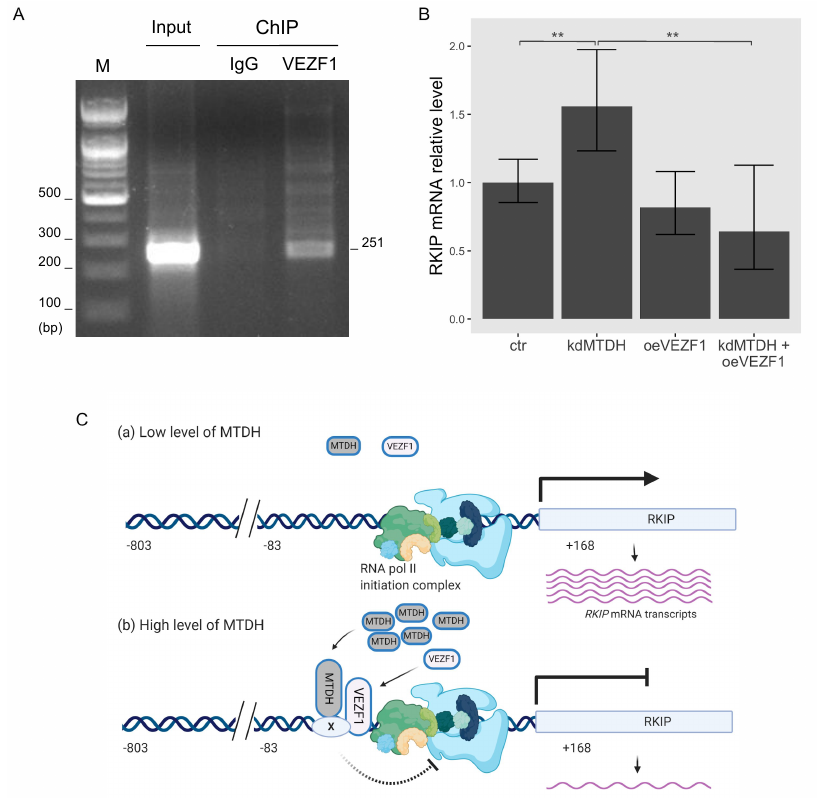
Figure 5. Functional linkage between VEZF1 and MTDH in RKIP transcription. ( A ) Chromatin immunoprecipitation (ChIP) assay of the RKIP promoter with VEZF1. MCF-7 cells were cross-linked with 4% formaldehyde and lysed with sonication. DNA fragments were immunoprecipitated with anti-VEZF1 antibodies (VEZF1) or IgG as a negative control (IgG), and a specific DNA fragment of 251-bp was amplified with a pair of RKIP primers described in “Materials and Methods”. For input control, the purified DNA fragments were amplified. Amplified DNA fragments were separated on a 1% agarose gel and visualized by EtBr staining. The first lane indicates 100 bp size markers. ( B ) qRT-PCR analysis. The relative RKIP mRNA transcripts were determined in each condition: control ( ctr ), MTDH knockdown ( kdMTDH ), VEZF1 overexpression ( kdVEZF1 ), and MTDH knockdown and VEZF1 overexpression ( kdMTDH + oeVEZF1 ). PCR products amplified by RKIP primers (Figure 3A) were normalized to GAPDH. Data represents the means ± S.D of the PCR reactions in triplicate. ** <0.01 p -value ( C ) A schematic diagram for the MTDH-dependent inhibition of RKIP transcription. The transcriptional activity of RKIP gene is elevated in low level of MTDH (a), and suppressed in high level of MTDH (b), presumably by blocking the action of RNA polymerase II initiation complex. Factor X indicates an unknown protein. This figure was created with BioRender.com, accessed on 11 February